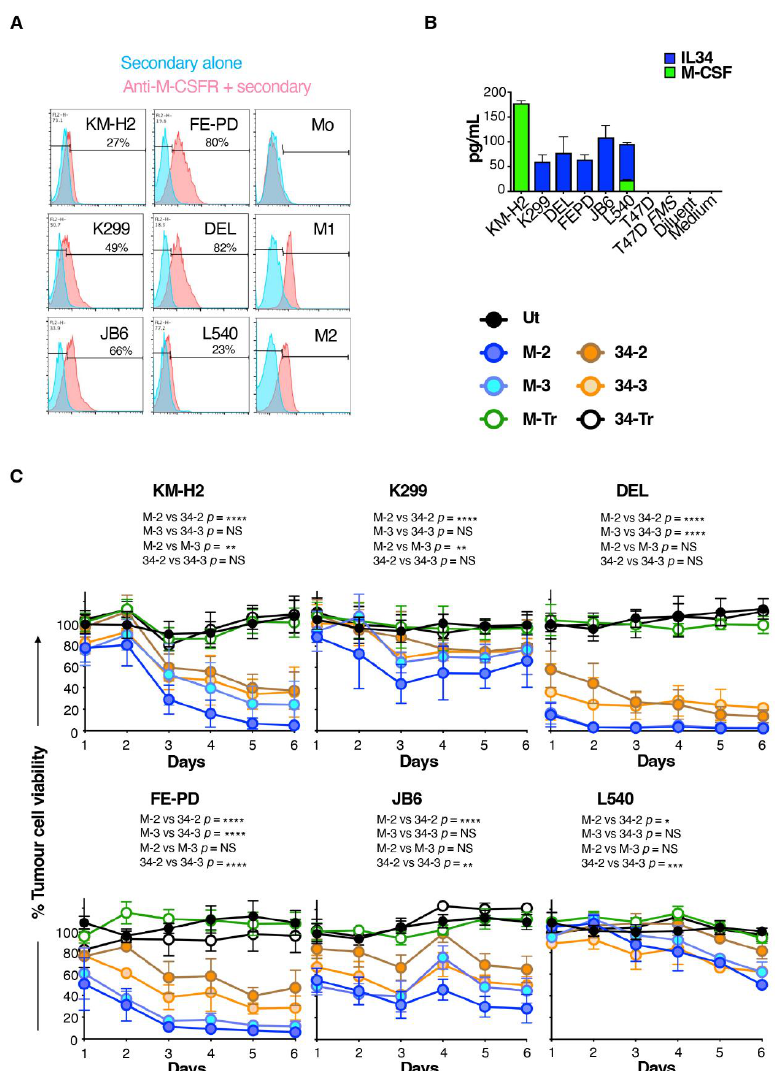
Figure 4. Lymphoma cell killing activity of M-CSFR-specific CAR T-cells. ( A ) Flow cytometry analysis of cell surface M-CSFR expression by the specified lymphoma cell lines, making comparison with monocytes (Mo) and M1- or M2-polarised macrophages as controls. ( B ) ELISA analysis of conditioned medium collected from the specified lymphoma cell lines for IL-34 and M-CSF (mean ± SD, n = 3). ( C ) T-cells were engineered to express the specified CARs and then co-cultivated at a 1:1 ratio with the indicated lymphoma cell lines. Lymphoma cell viability was determined each day using a luciferase assay (mean ± SD, n = 5) and was normalised to lymphoma cells cultured without T-cell addition (set to 100%). Two-way ANOVA was performed (comparing tumour cell viability over days 1 – 6). Selected significant differences are indicated. **** p < 0.0001; *** p < 0.001; ** p < 0.01; * p < 0.05.